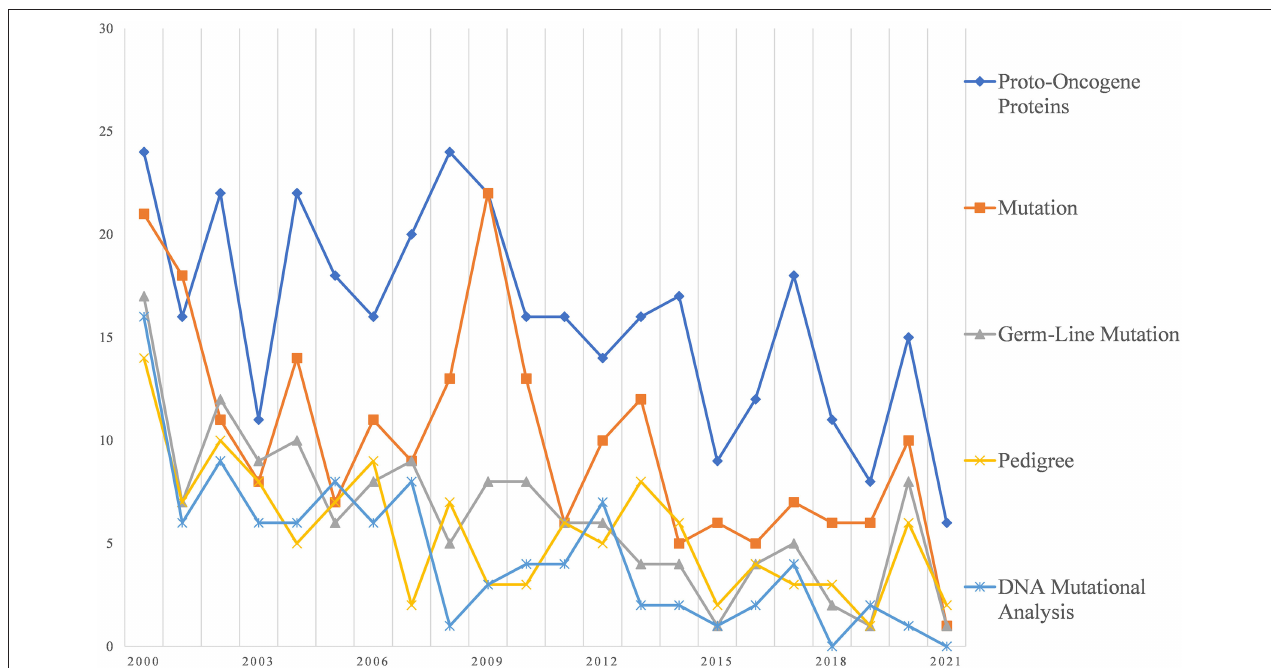
FIGURE 4 | Research foci trends related to basic research.